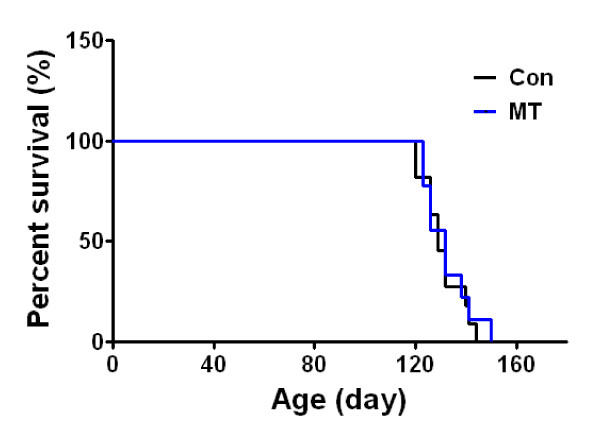
The effect of melittin on the survival rate of hSOD1G93A mice. Melittin treatment did not alter the survival of hSOD1G93A mice, as shown by a Kaplan-Meyer analysis. Melittin-treated (0.1 μg/g/98day, n = 11) or saline-treated transgenic hSOD1G93A mice (n = 11) had comparable median lifespans (132 ± 3.2 days and 129 ± 2.5 days, respectively). Con: saline- treated mice, MT: melittin -treated mice